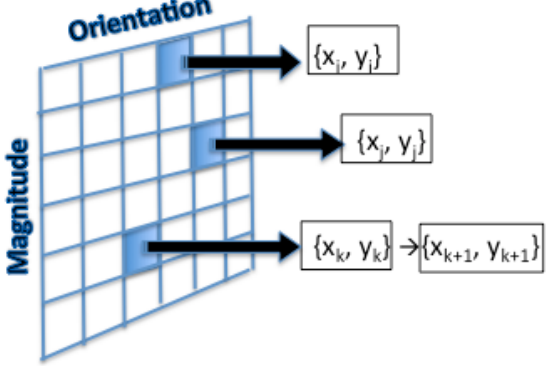
Figure 1. Inverse Gradient Hash Map Data